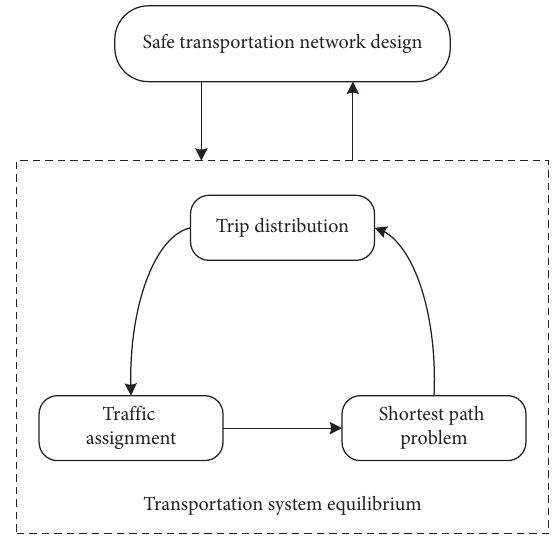
Figure 1: The framework for safe transportation network